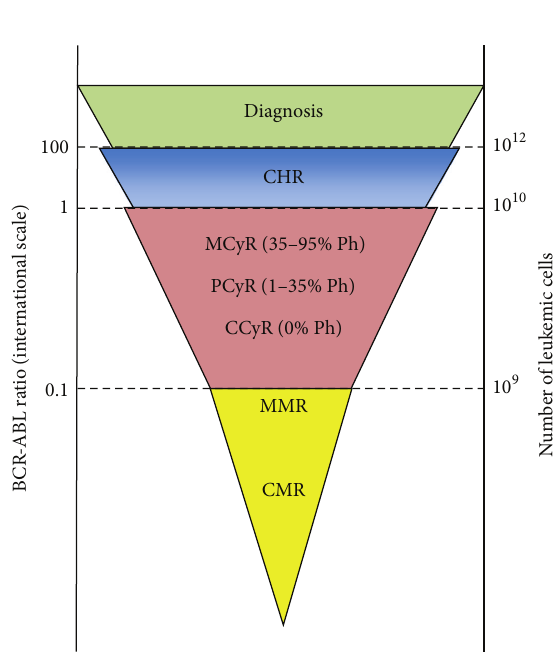
Figure 2: Monitoring response to therapy in CML. Three levels of disease control can be defined in CML: Complete Hematologic Response (CHR), Cytogenetic Response (CyR) (Minor, Partial or Complete) and Molecular Response (MR) (Major or Complete) (Adapted from